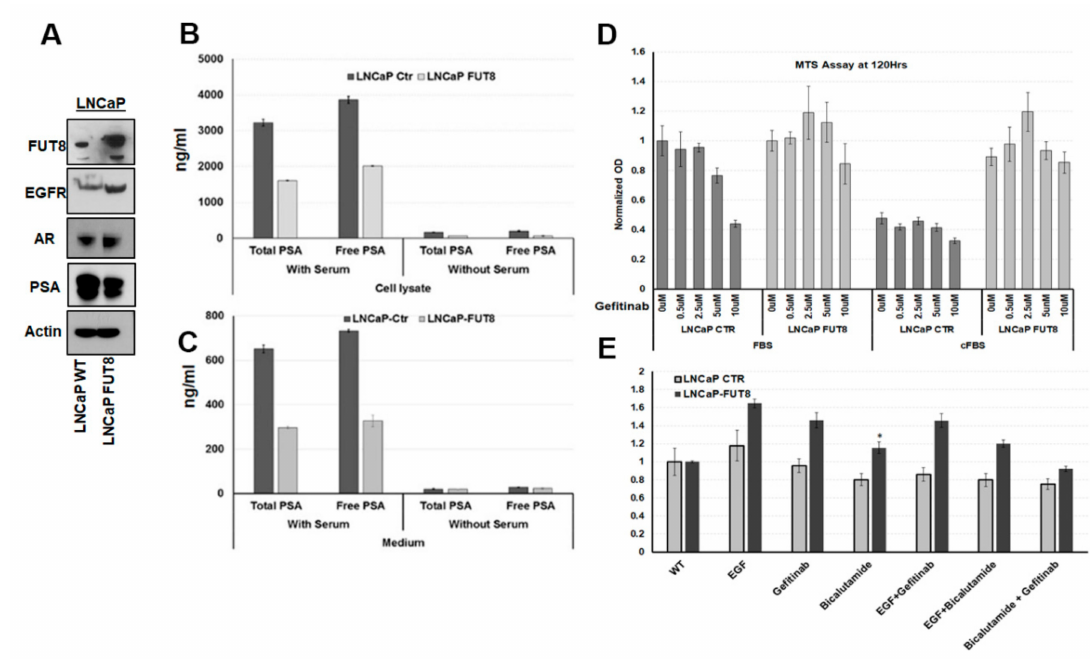
Figure 3. FUT8 suppresses the Prostate specific antigen (PSA) production by activating EGFR. Western blot analysis showing overexpression of EGFR proteins in LNCaP-FUT8 cells that were stably selected to express FUT8. A lower expression of PSA protein was observed in the same LNCaP-FUT8 cells when compared to the wildtype LNCaP Ctr ( A ). The Hybritech PSA ELISA assay to quantify the total and free PSA in LNCaP Ctr and LNCaP-FUT8 cell lysate ( B ) and in cultured condition media ( C ). The 3-(4,5-dimethylthiazol-2-yl)-5(3-carboxymethonyphenol)-2-(4-sulfophenyl)-2H-tetra zolium ( MTS) assay in LNCaP-FUT8 and LNCaP ctr cells that were treated with di ff erent concentrations of Gefitinib (0-10 uM) in normal and charcoal stripped cFBS containing media ( D ). MTS assay in LNCaP-FUT8 and LNCaP ctr cells that were treated with Gefitinib (5 uM or bicalutamide (10 uM) alone or in combination with both drugs for 72 h ( E ). The asterisks represent statistical di ff erence between the two treatments at p < 0.05 Student’s t-test. Error bars represent ±